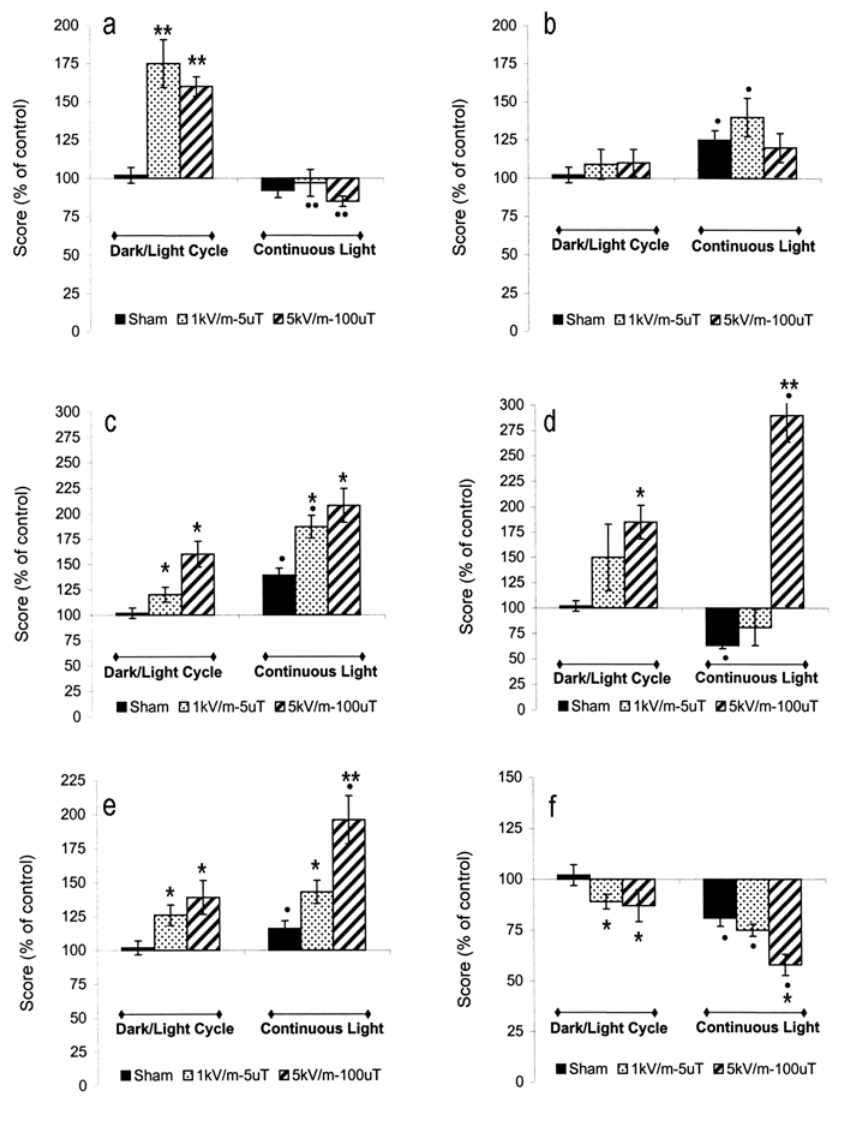
FIGURE 2. Morphometric analyses performed on semi-thin sections of thymus from rats housed in a DL or under CL. Rats were also sham exposed or exposed for 8 months to 50-Hz sinusoidal EMF at two levels of field intensity (1 kV/m, 5 µ T and 5 kV/m, 100 µ T). Mitoses (a), apoptosis (b), necrosis (c), clustered cell death (d), total cell death (e), and cell-cell adhesion (f) were scored semi-quantitatively (see also Materials and Methods) and data are expressed as percentage of variations compared to control sham-exposed rats housed in a DL ± SD. * p < 0.05; ** p < 0.001 significance vs. sham-exposed rats with the same light conditions. ● p < 0.05, ●● p < 0.001 significance vs. sham- or EMF-exposed rats in a